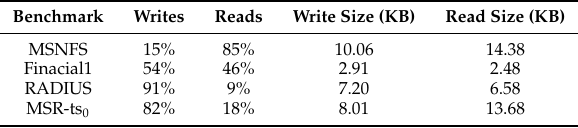
Table 4. Read/write ratio of workload benchmark